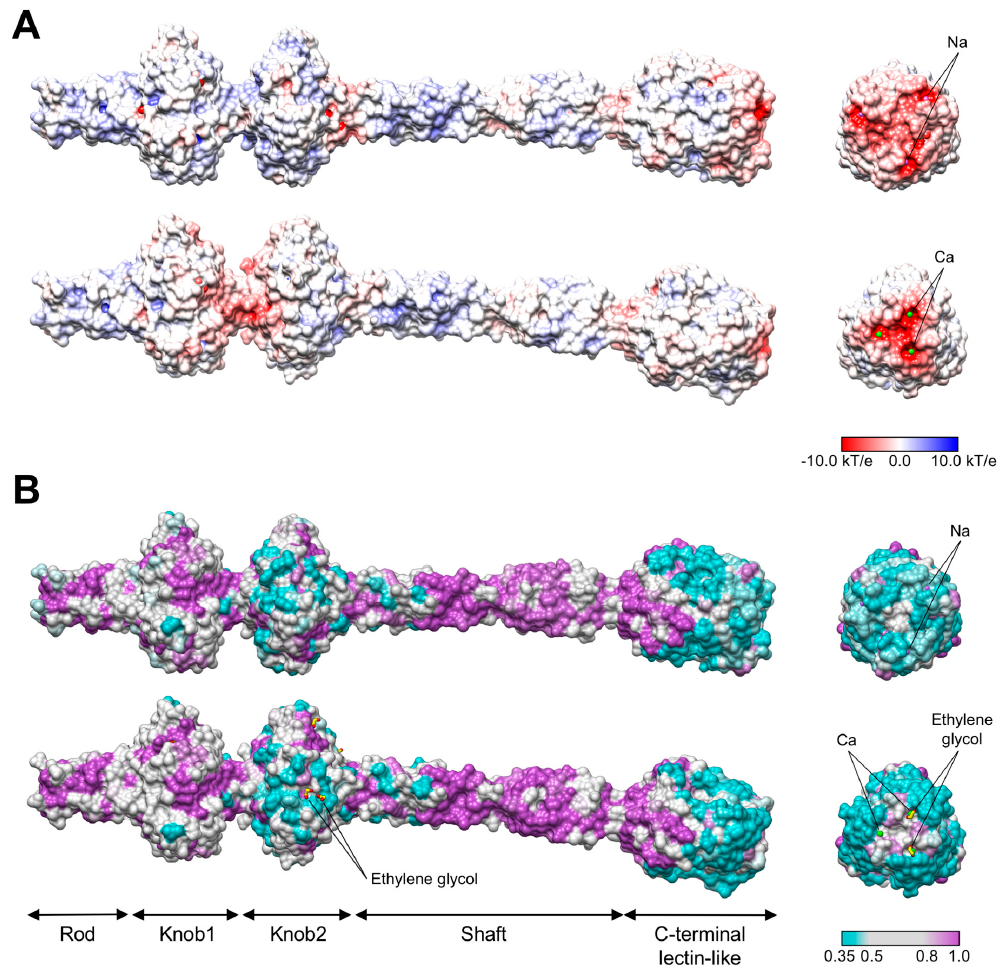
Figure 6. Surface properties of pyocin fibers. ( A ) Surface-mapped electrostatic potential of the R1 (top panel) and R2 (lower panel) fibers. ( B ) Sequence diversity of the surface residues of the R1 (top panel) and R2 (lower panel) fibers. The color code is given as a color bar. Panels on the left: side view. Panels on the right: C-to-N end-on view.